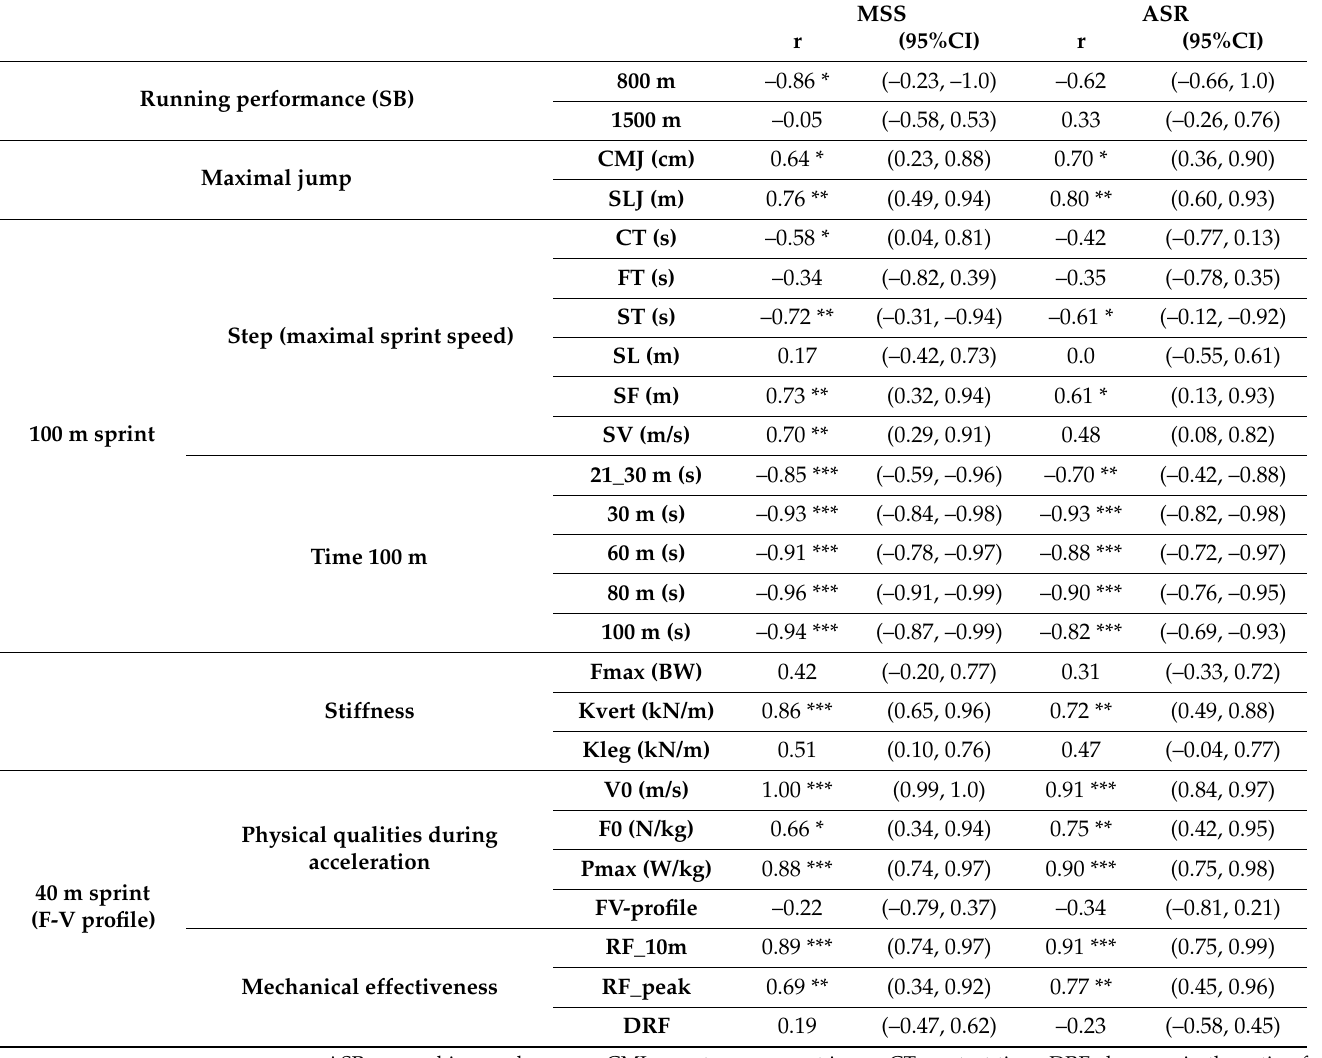
Table 3. Correlations between Maximal Sprint Speed and Anaerobic Speed Reserve with sprint, jump performance and sprint mechanical characteristics of